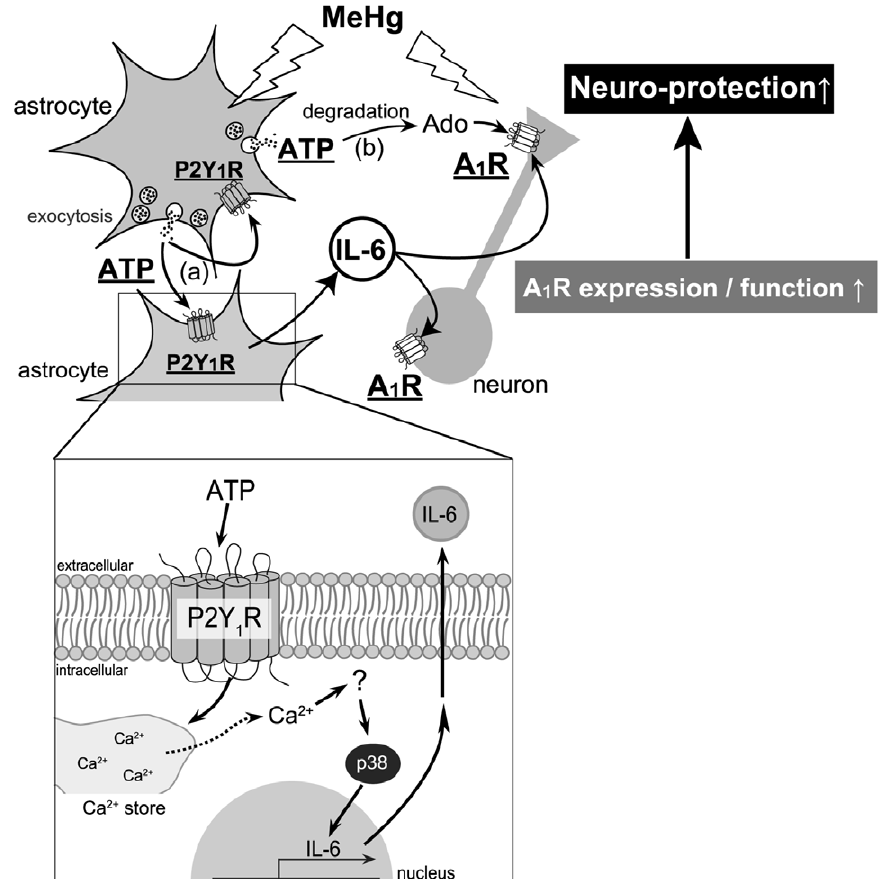
Figure 7. A schematic diagram, illustrating mechanisms underlying astrocyte-mediated neuro-protection against MeHg. MeHg stimulates exocytosis of astrocytic ATP that functions as both (a) autocrine and (b) paracrine signals to reveal neuro-protection, i.e., (a) the released ATP as an autocrine signal, autostimulates P2Y 1 receptors to induce IL-6 that upregulates neuronal adenosine A 1 receptors, (b) the released ATP from astrocytes being degraded into adenosine, stimulates neuronal adenosine A 1 receptors and suppresses neuronal excitability as a paracrine signal, thereby leading to further inhibition of neuronal excitability. As for mechanisms for IL-6 synthesis and release, an increase in [Ca 2 + ]i in astrocytes mediated by P2Y 1 receptors, and subsequent p38 phosphorylation were involved (insert).